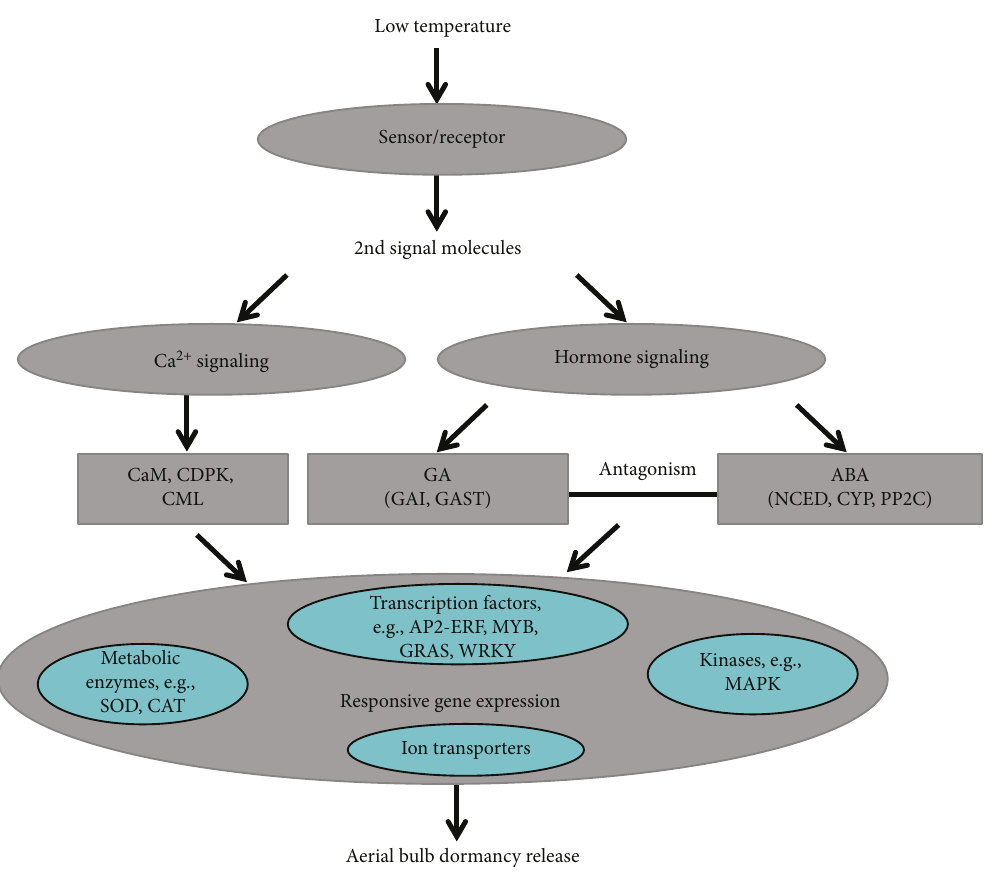
Figure 10: The regulatory mechanism of dormancy release during low-temperature treatment of aerial